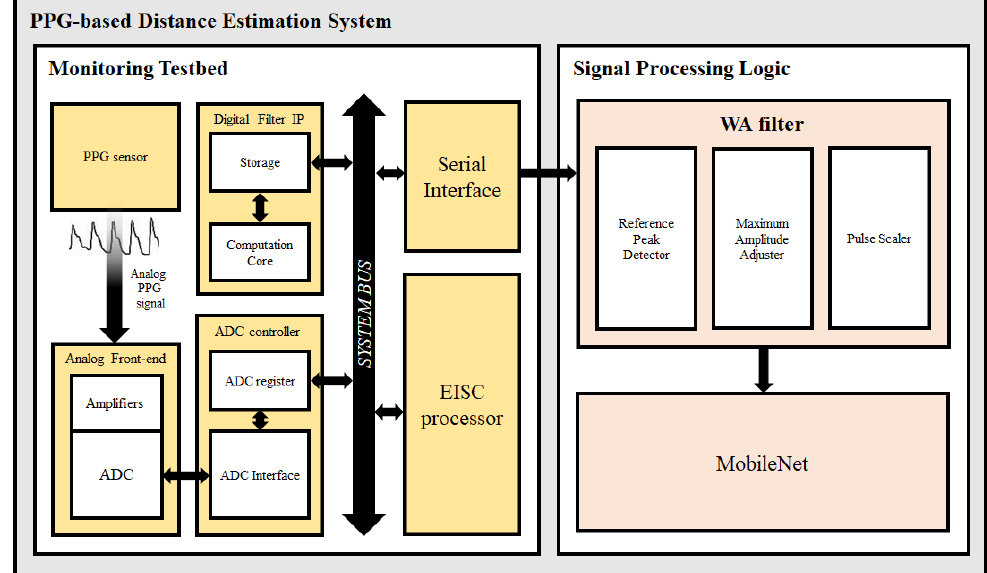
Figure 2. Block diagram of the proposed